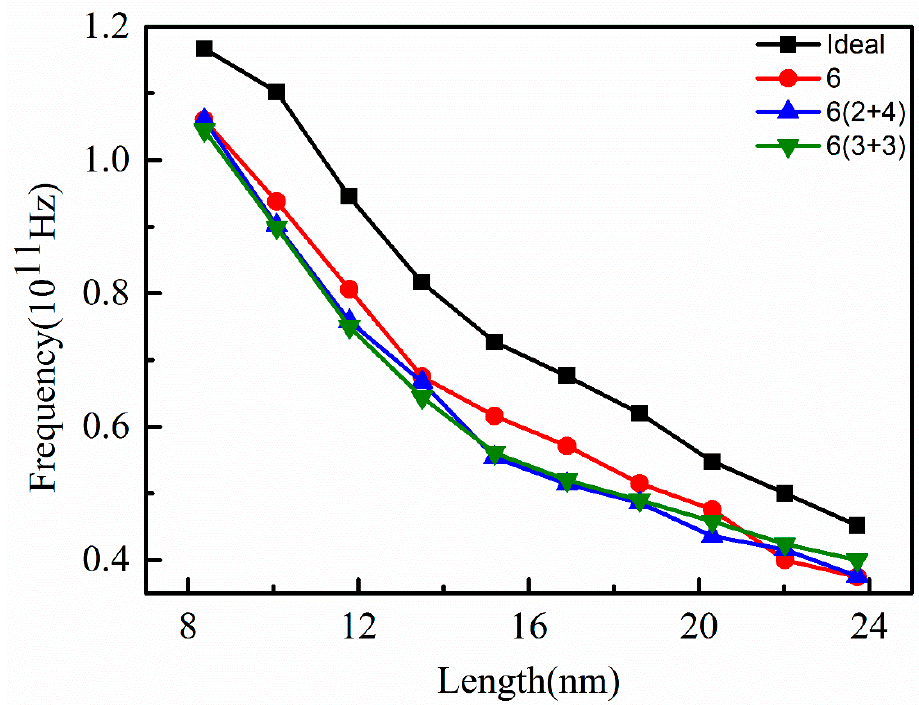
Figure 7. Variation of vibration frequency of graphene nanoribbon at different vacancy positions (V-6) with length.